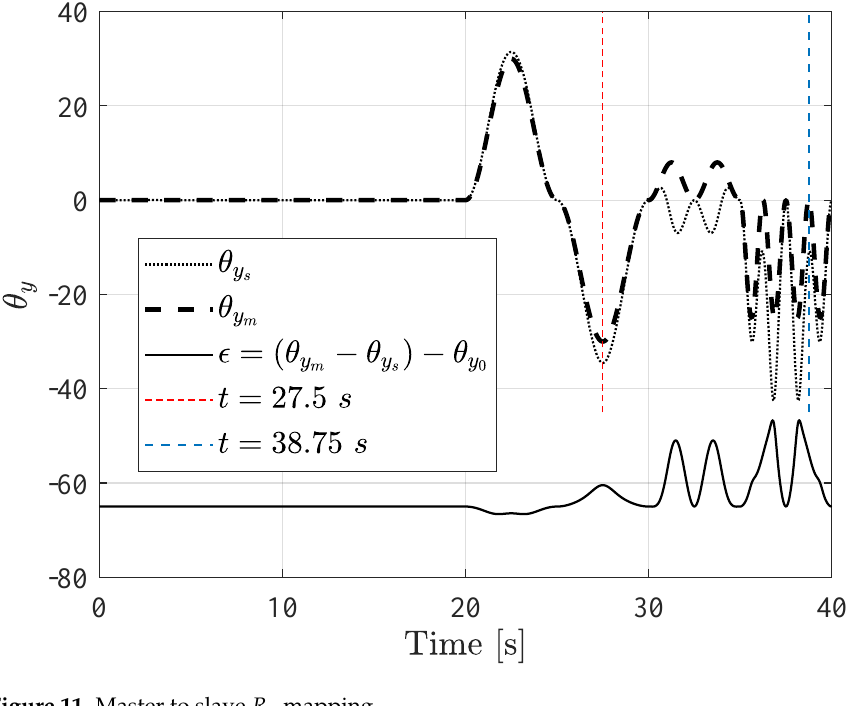
Figure 11. Master to slave R y mapping.